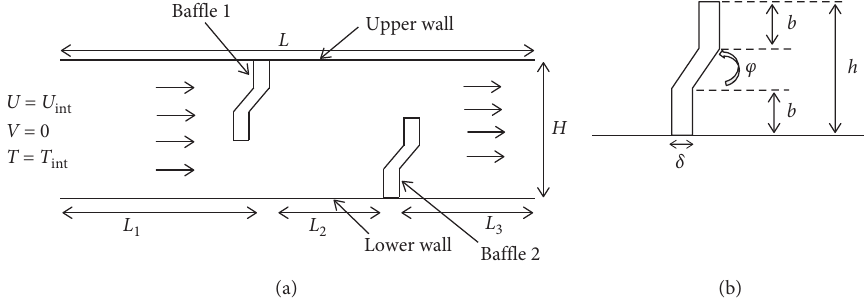
Figure 1: (a) Schematic of the physical model in the ( x , y ) plane. (b) Baffle dimensions: b � 0.03 m. Table 1: Dimensions of physical problem. Unit (m) L